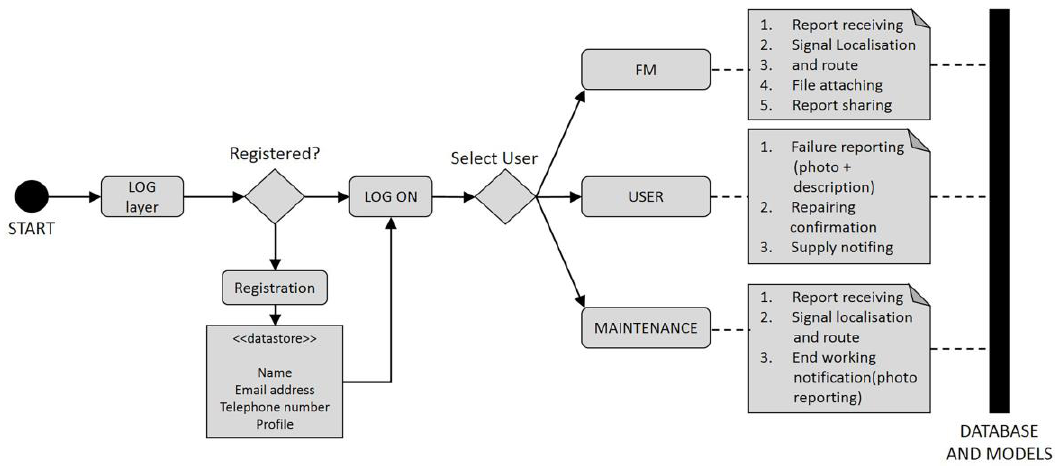
Figure 4. Indoor localization app: registration interface.